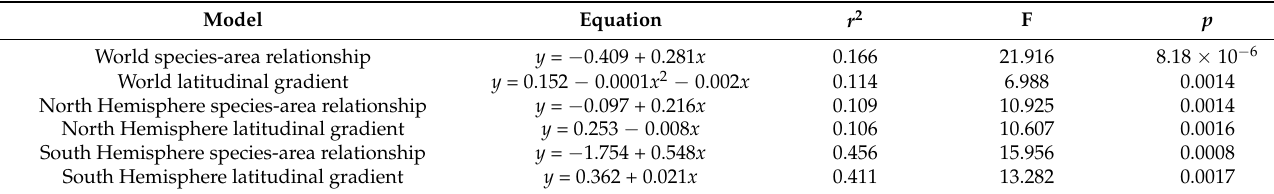
Table 2. Earwig species–area relationships and latitudinal diversity gradients for world mainland countries. Species–area relationships were modelled using the linearized version of the power function: log( S ) = z log( A ) + log( c ), where S is the recorded species richness at country level, A is country area, and z and c are estimated parameters. Latitudinal gradients were modelled with regressing residuals from the species–area relationships (SAR residuals) against country latitude with a second-order polynomial regression for the whole dataset and with linear regressions for the two hemispheres separately. r 2 = coefficient of determination; F = Fisher’s F; p =